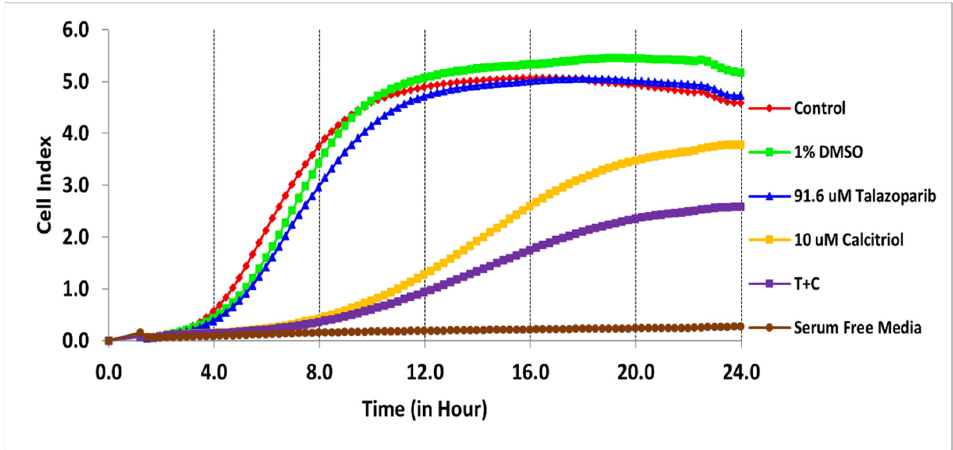
Figure 5. BT − 20 cell migration profiles. The experiment was performed in triplicate for each treatment. Real − time migration of BT − 20 cells, the slope represents the degree of cell migration (cell index) over time. Data are represented as the mean ± SD ( n = 3). The red color line is untreated control. The green color line is vehicle control (1% DMSO), and brown color line is negative control (serum − free media). Raw data and details of the statistical analysis can be found in Supplementary File S5 and Table S1, respectively.